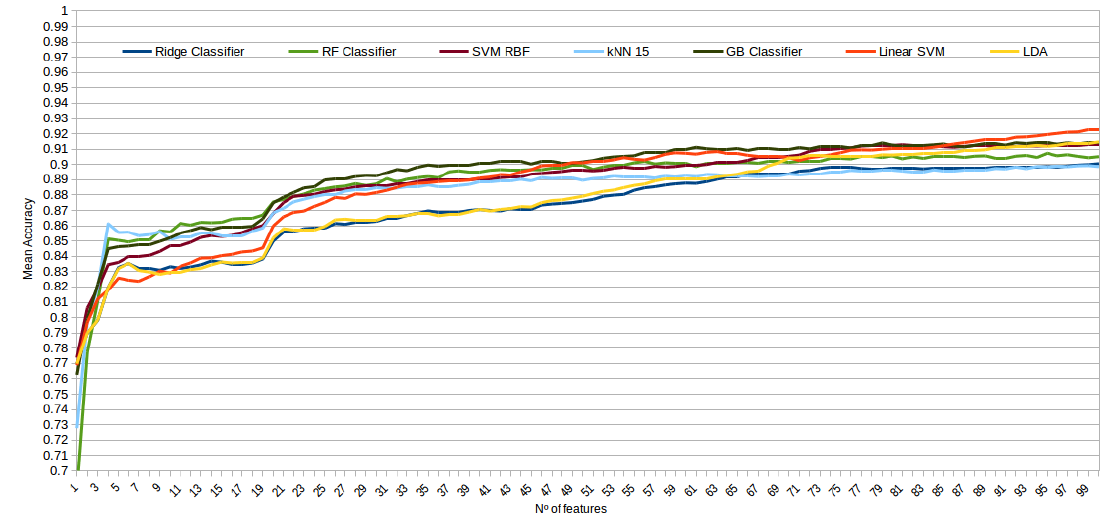
Figure 8. Evolution of the accuracy for each classifier tested with an increasing subset of features obtained with the trace ratio selector.